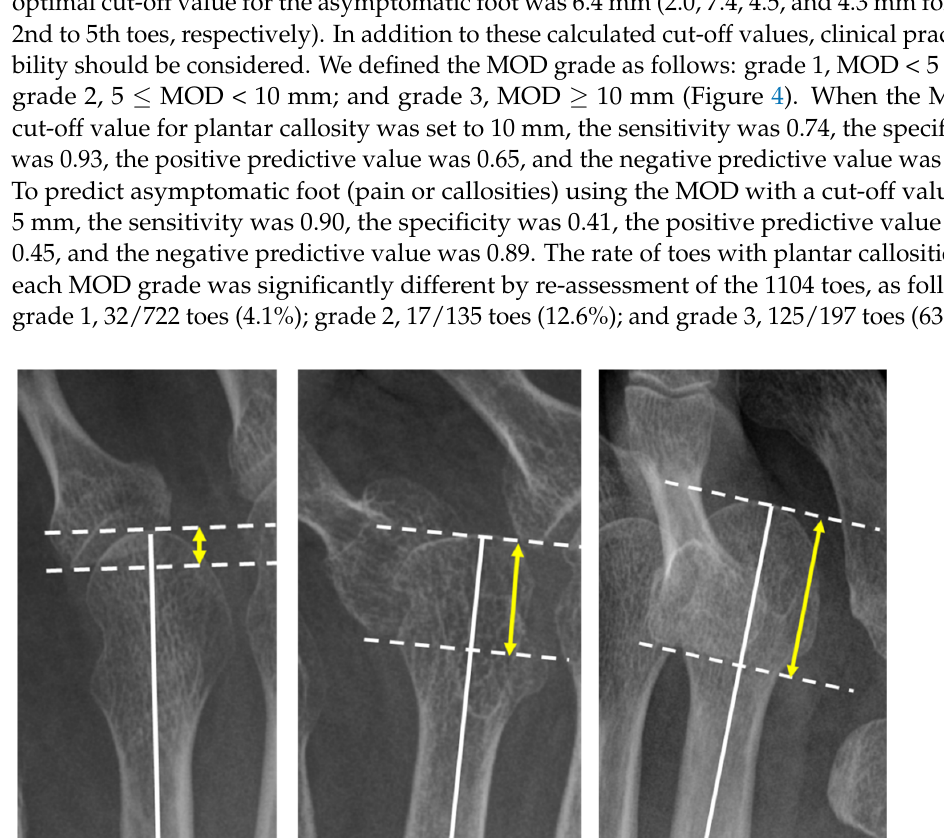
Figure 3. The ROC curve for predicting an ( A ) asymptomatic foot and ( B ) callosities by the MOD. The AUC was − 0.70 (95% CI [ − 0.67, − 0.73]) for an asymptomatic foot and 0.89 (95% CI [0.86–0.92]) for the prediction of callosities. ROC: receiver operating characteristic. AUC: area under the curve.